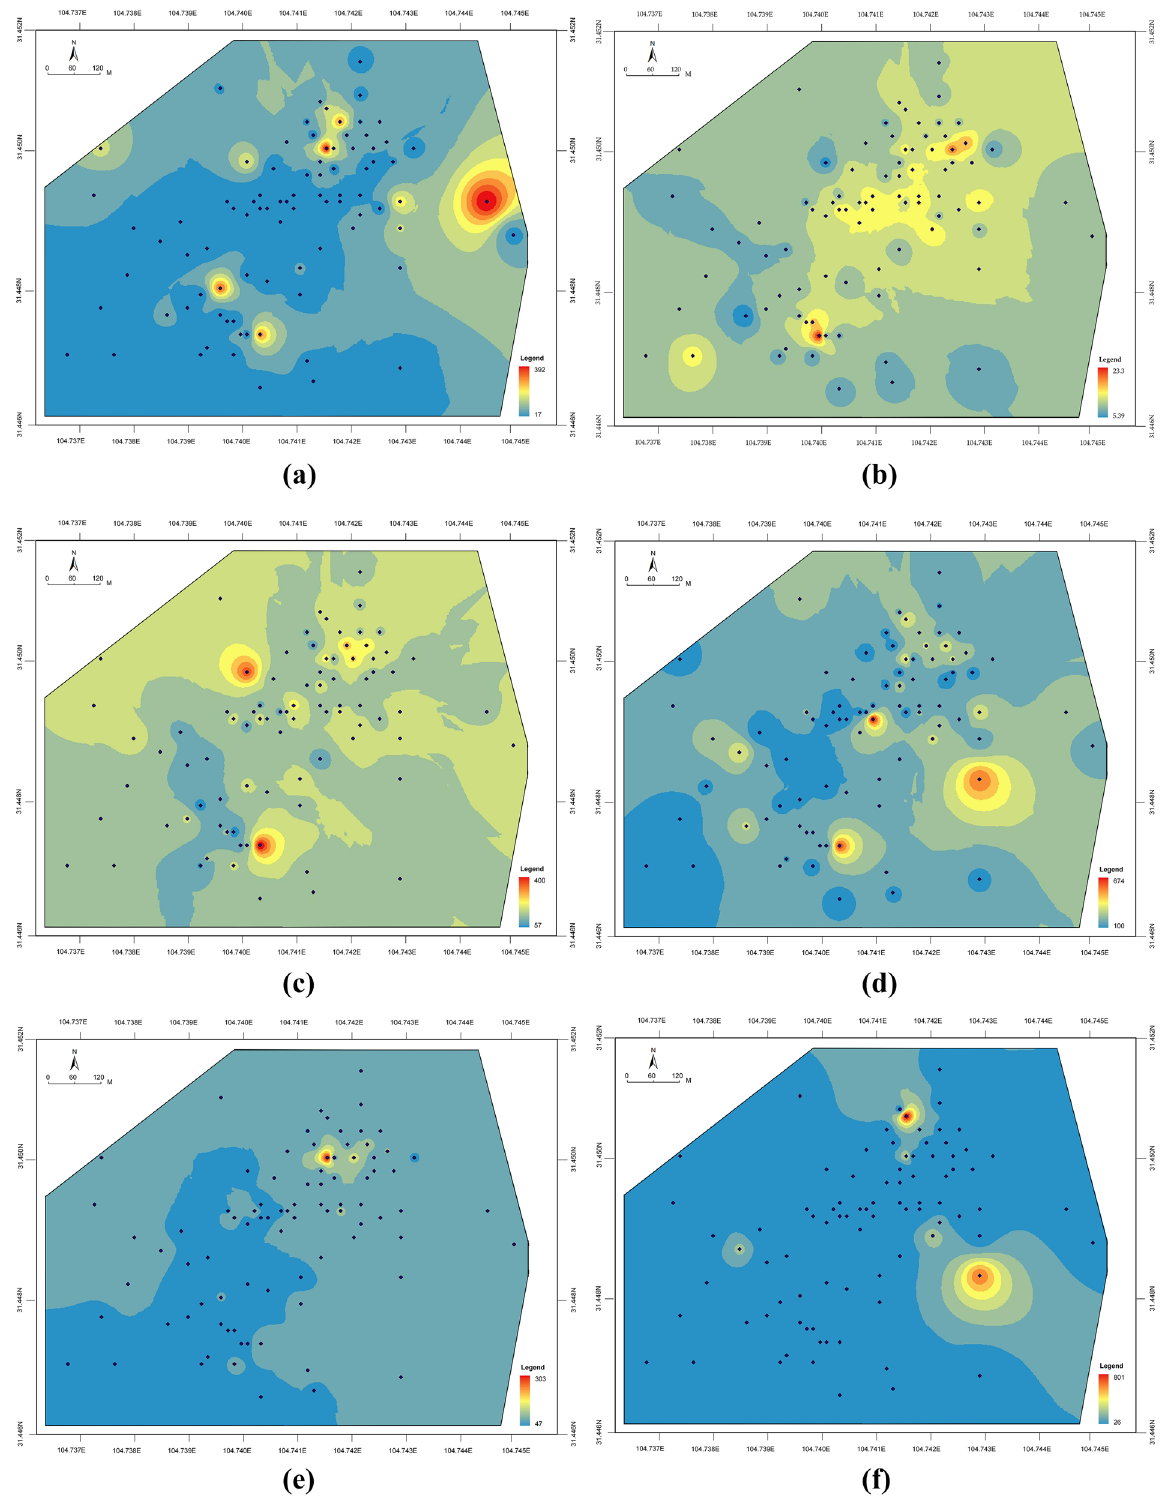
Figure 2. Spatial distribution of heavy metal concentrations in soil: ( a ) Pb; ( b ) As; ( c ) Cr; ( d ) Zn; ( e ) Ni; ( f ) Cu; The color range spanning from blue across yellow to red, represents a spectrum of low to high concentration of heavy metals in the soil. (Note: ArcGIS, Version 10.3, ESRI was used to create the map in this